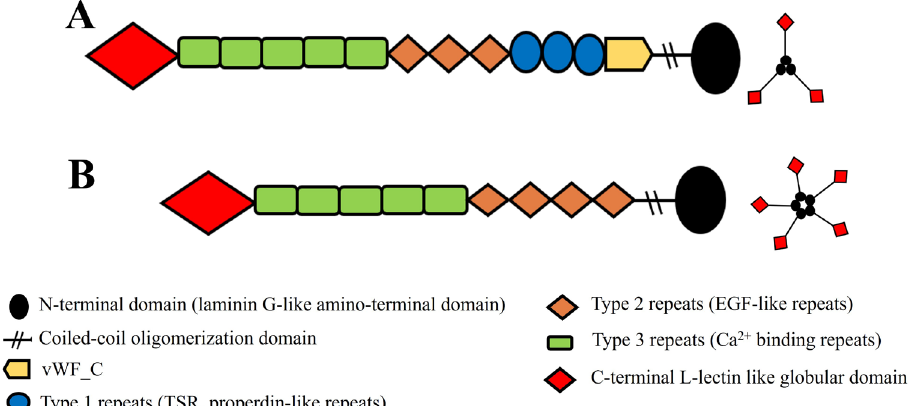
Figure 1. Simple representation of domain architectures of TSP glycoproteins. A. Domain architectures of group A (TSP1 and TSP2) and its trimeric structure; B. domain architectures of group B (TSP3, TSP4, TSP5), and its pentameric structure. EGF: epidermal growth factor; vWF_C: von Willebrand type C